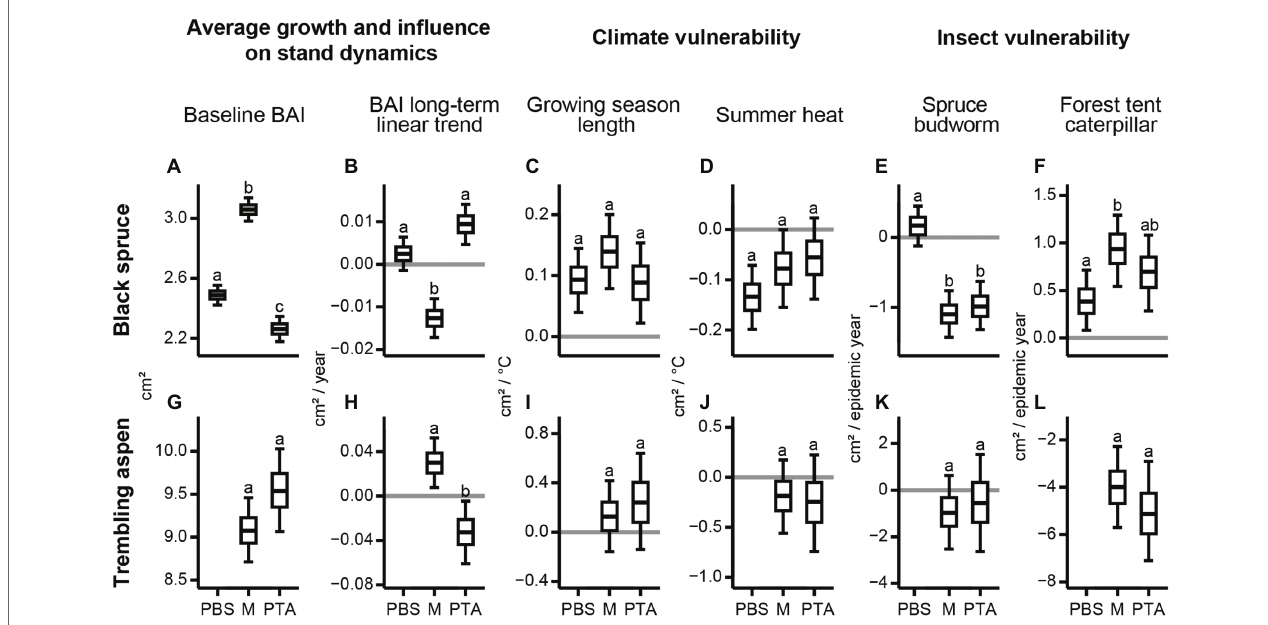
FIGURE 5 | Posterior distributions for parameters of the linear Bayesian models used to explain mean BAI chronologies for specific composition type as a function of climate and occurrence of insect epidemics. Boxplots compare the parameters for black spruce and trembling aspen in PBS, mixed stands (M), and PTA. Different letters represent posterior distributions with <10% overlap. We show the posterior distributions for (A,G) baseline BAI, (B,H) BAI long-term linear trend, (C,I) growing season length, (D,J) summer heat, (E,K) spruce budworm, and (F,L) forest tent caterpillar according to species and composition